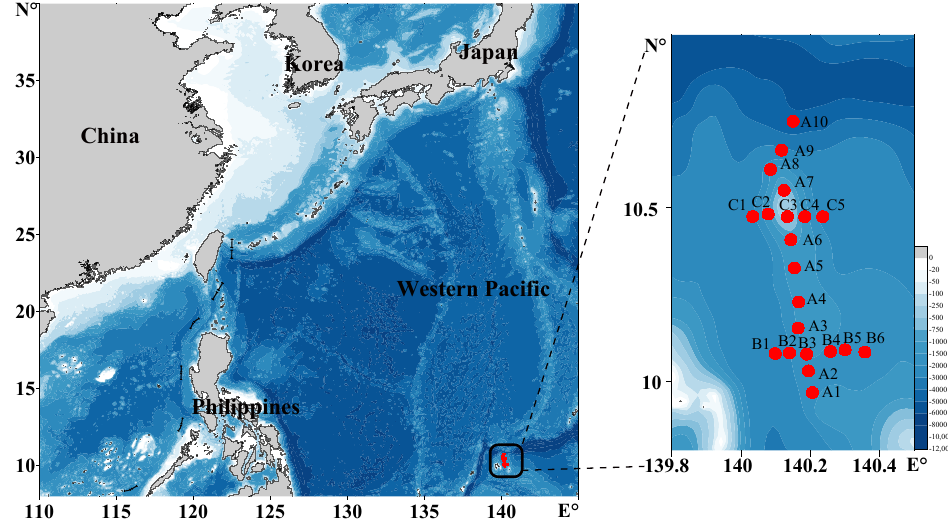
Figure 1. Sampling sites in the Western Pacific seamount regions. Red dots represent sampling